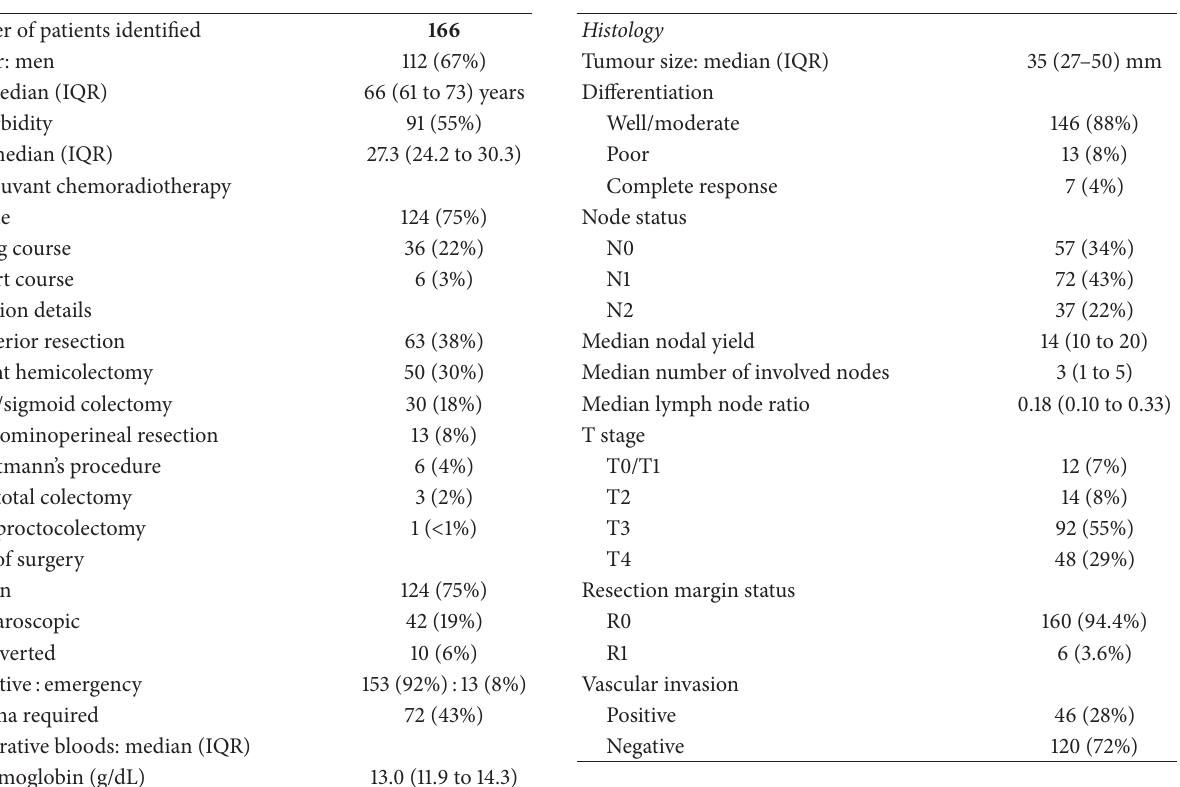
Table 2: Histological tumour